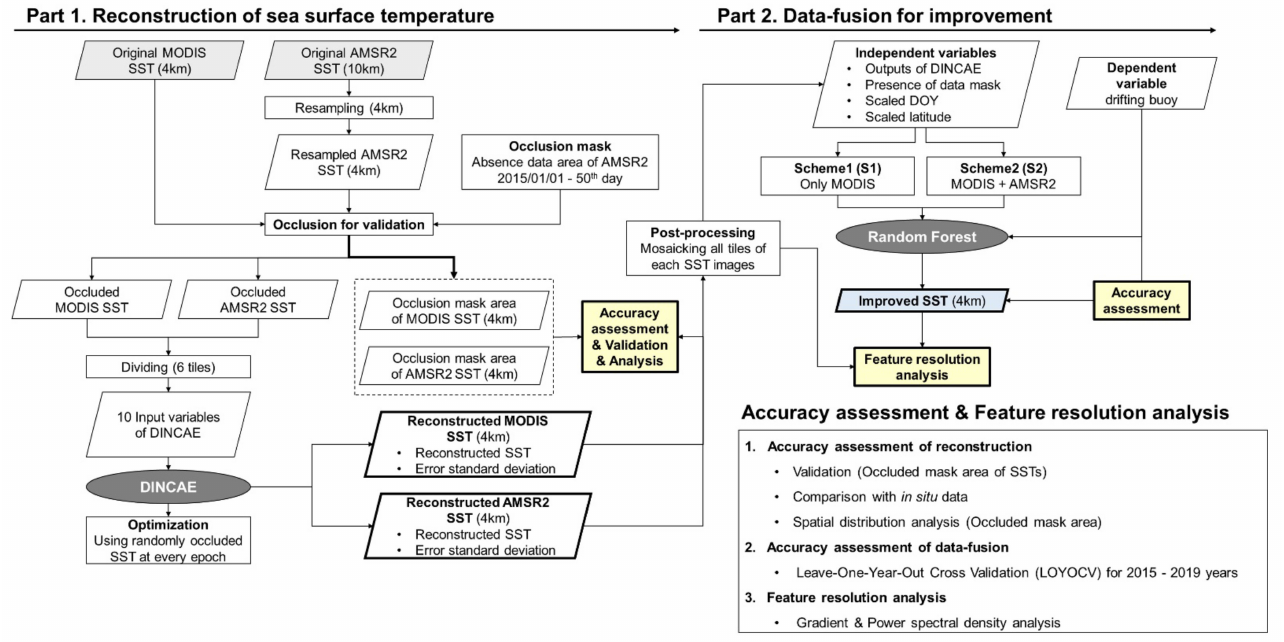
Figure 3. The overall flow diagram of the proposed approach for SST reconstruction and improvement through data